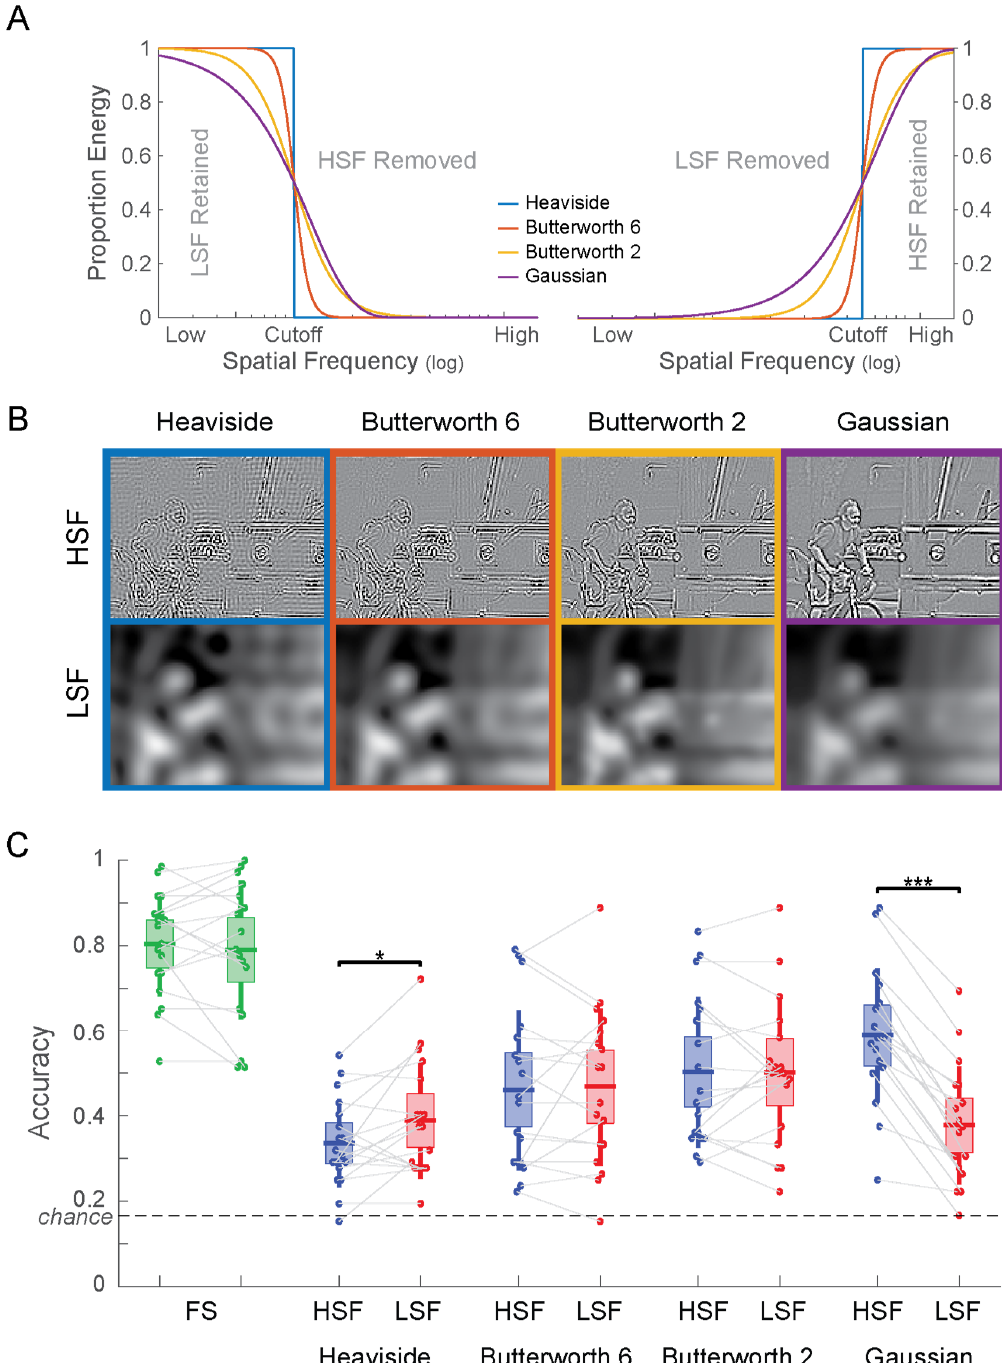
Figure 4. ( A ) Frequency response of the four filter types both as low-pass filters (left) and as high-pass filters (right). ( B ) Example stimuli for Experiment 2. Note the strong ringing artifacts for the Heaviside filter, which successively decrease for smoother filters (from left to right). In the Gaussian HSF image (top-right) spillover of LSF into the HSF are clearly visible, e.g., on the face and the arms of the cyclist. ( C ) Accuracy of scene categorization for Experiment 2. * p < 0.05; *** p <